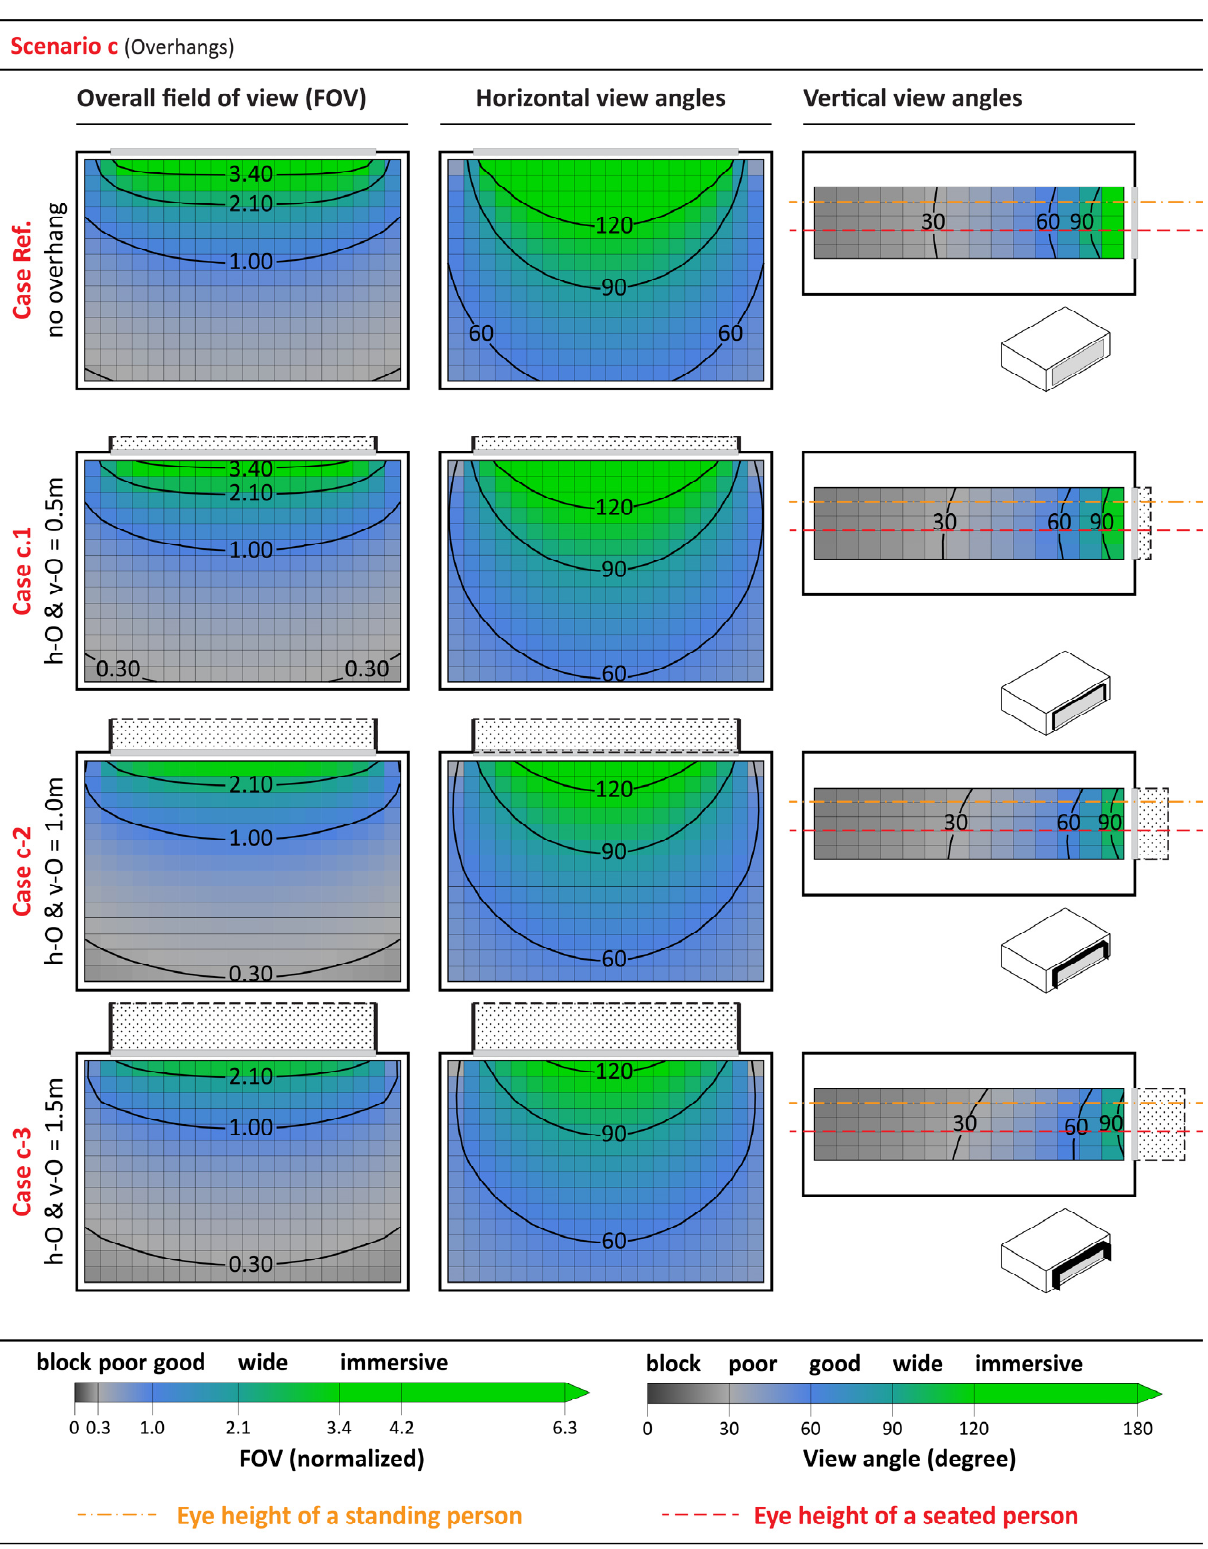
Figure 13. Impacts of external overhangs installed around window edges on the distributions of overall, horizontal, and vertical FOVs for case studies of scenario-c.